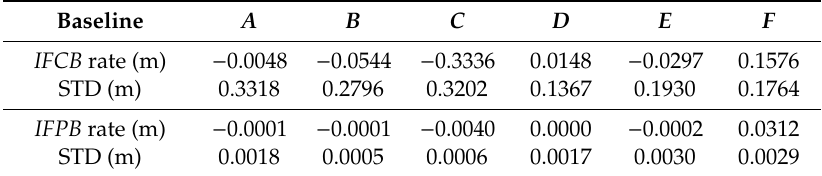
Table 2. Estimated IFCB rates, IFPB rates, and the corresponding standard deviations (STDs) for di ff erent